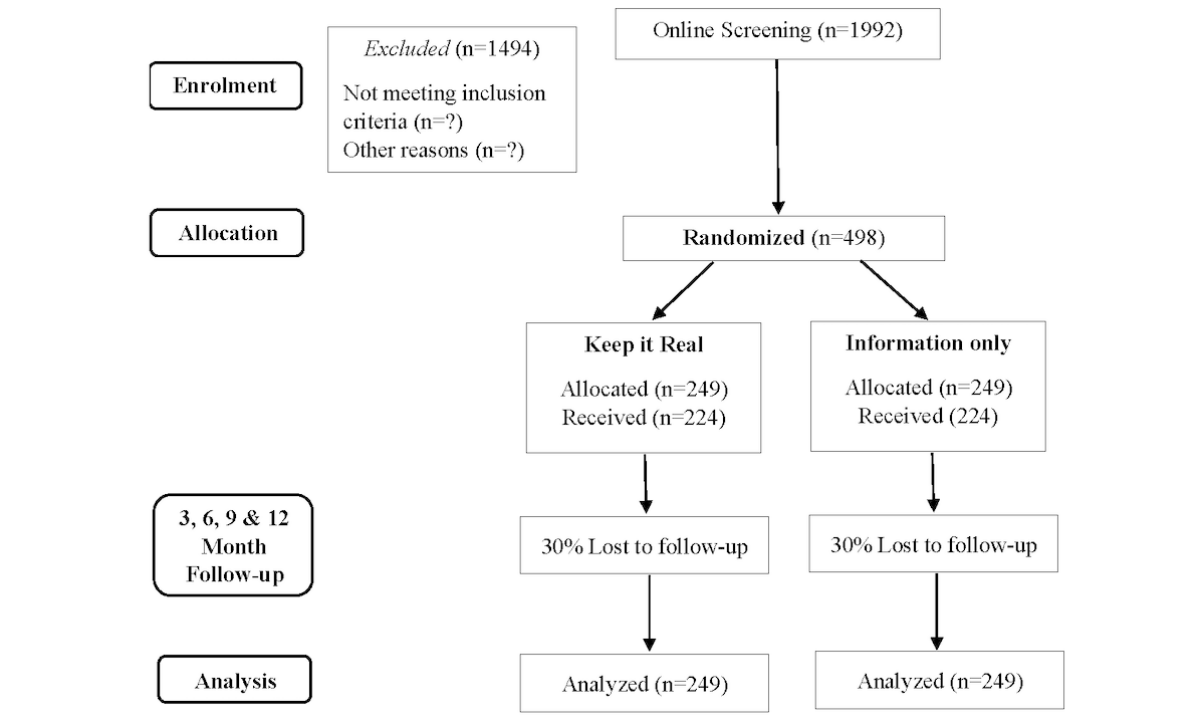
Figure 1. Anticipated CONSORT (Consolidated Standards of Reporting Trials)